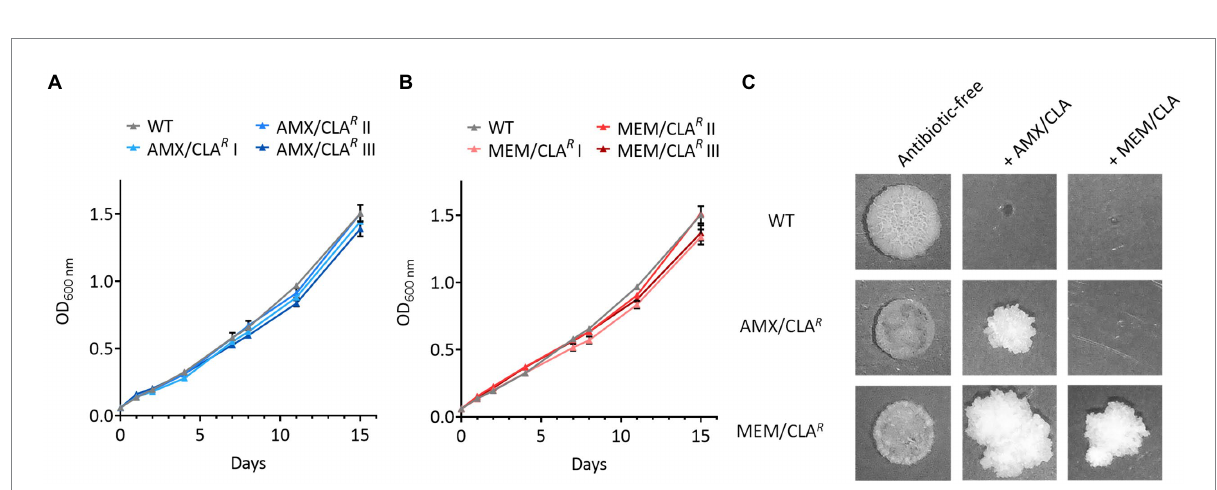
FIGURE 3 Growth of Mtb -resistant isolates and their parental strain in broth and agar medium. (A) Growth curves of the wild type (WT) and mutants selected with amoxicillin/clavulanate. (B) Growth curves of the WT and mutants selected with meropenem/clavulanate. Optical density at 600 nm (OD 600 ) was measured over 15 days for all cultures of both groups of isolates. Triangles show the mean value of two biological replicates and error bars represent standard deviation. (C) Spots of the parental strain and one representative mutant of each group platted on antibiotic-free (11 days